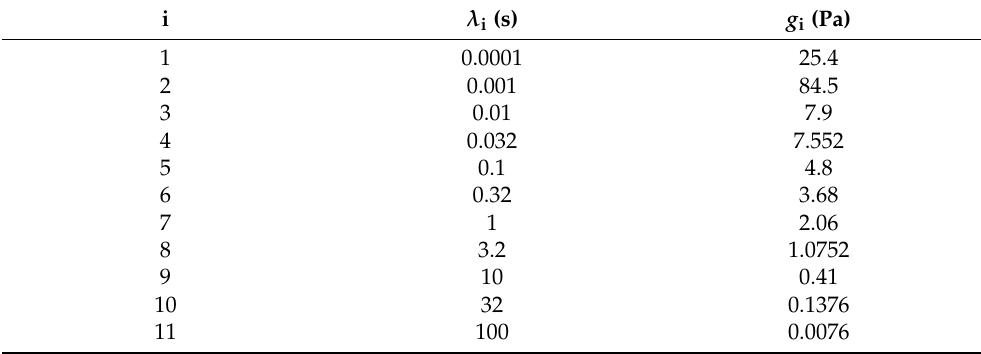
Table 3. Relaxation spectrum of the polyacrylamide solution given by Greener and Connelly [36]. i λ i (s) g i